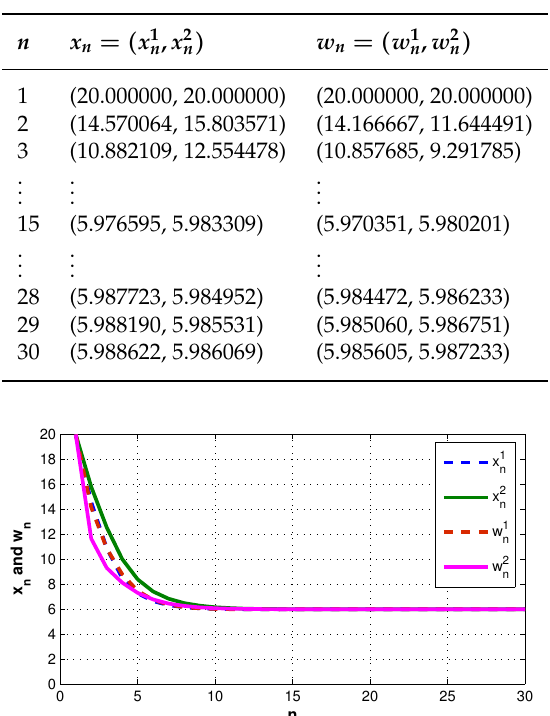
Table 1. The values of { x n } and { w n } with initial values x 1 = ( 20,20 ) , w 1 = ( 20,20 ) and n = N = 30.